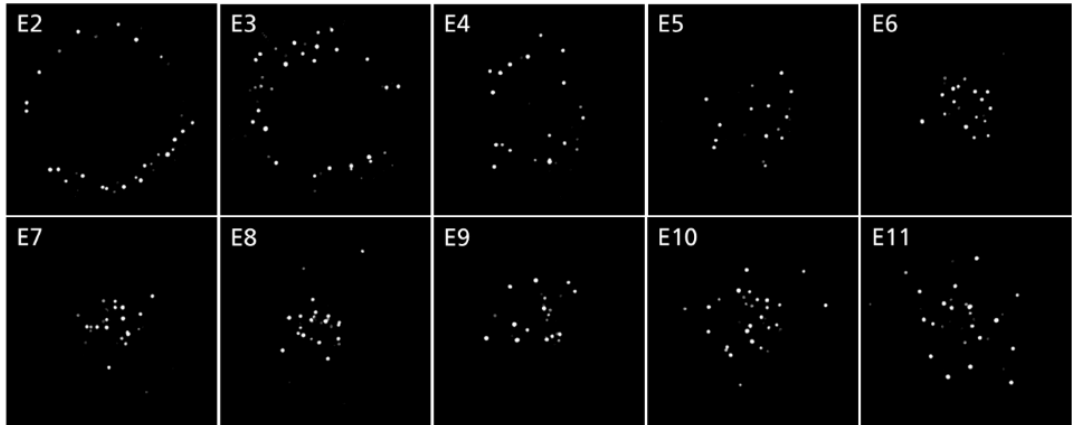
Figure 9. Selected examples of individual pictures of powder-gas jet measurements taken at a distance